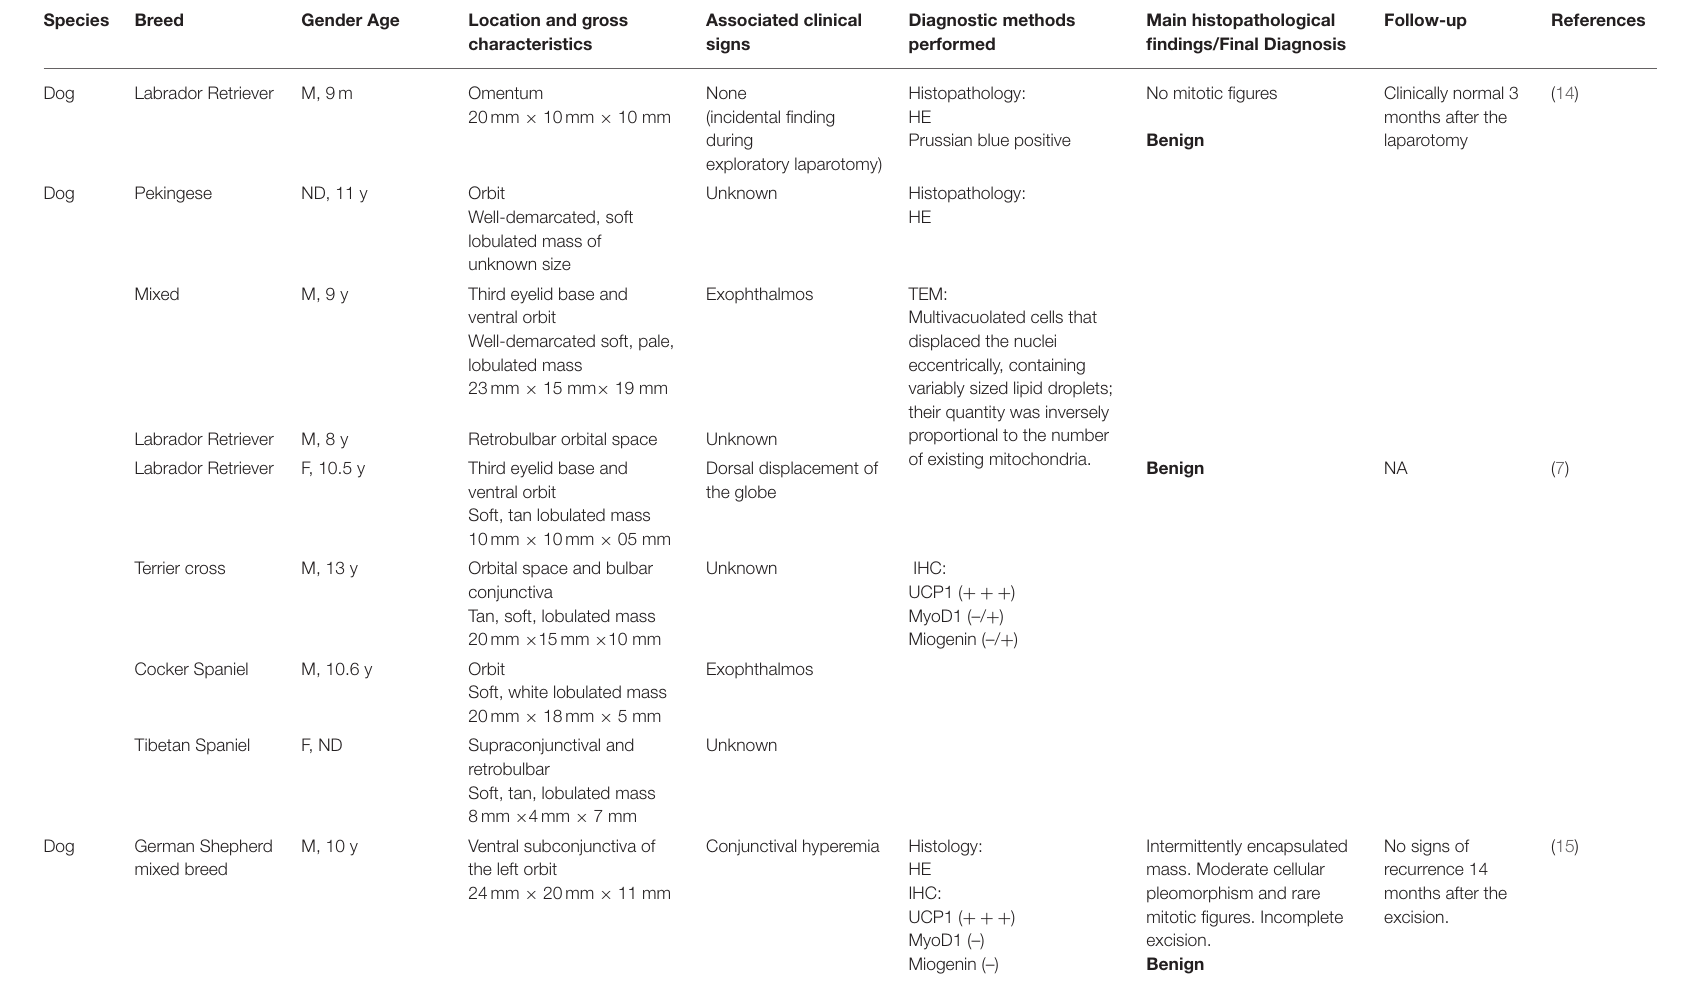
TABLE 1 | Literature available data concerning spontaneously occurring hibernomas in animals.